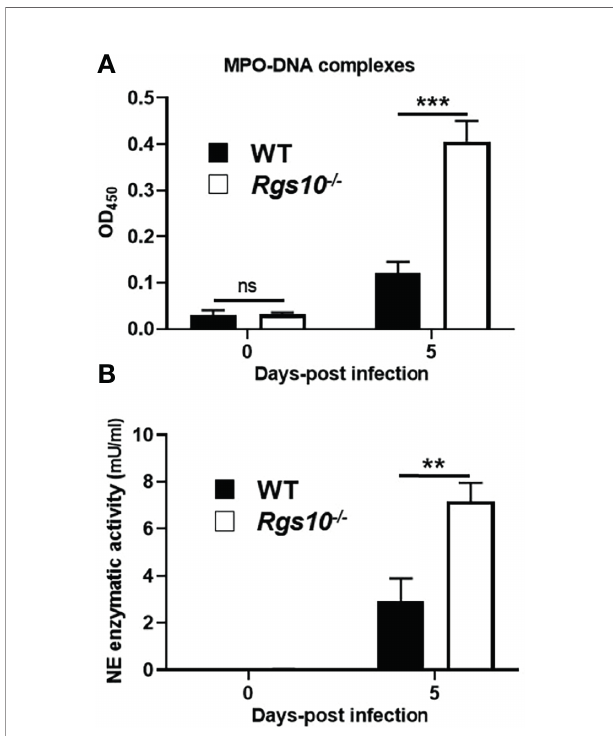
FIGURE 6 | Neutrophil activation markers are higher in the lungs of PR8- infected Rgs10-/- mice. Neutrophil extracellular traps were measured in collected lung BALFs from uninfected (0 dpi) and infected WT and Rgs10-/- mice (n = 7) with 100 PFU of PR8 virus (A) at 5 dpi using ELISA that detects MPO-DNA complexes, indicative of NETs. (B) Neutrophil elastase enzymatic activity was detected in cell-free BAL supernatants of mice at 0 and 5 dpi by using the NE-speci fi c fl uorogenic substrate. Data were analyzed for statistical differences using unpaired t-test between groups. Data are presented as mean ± SEM where **p < 0.01; ***p <